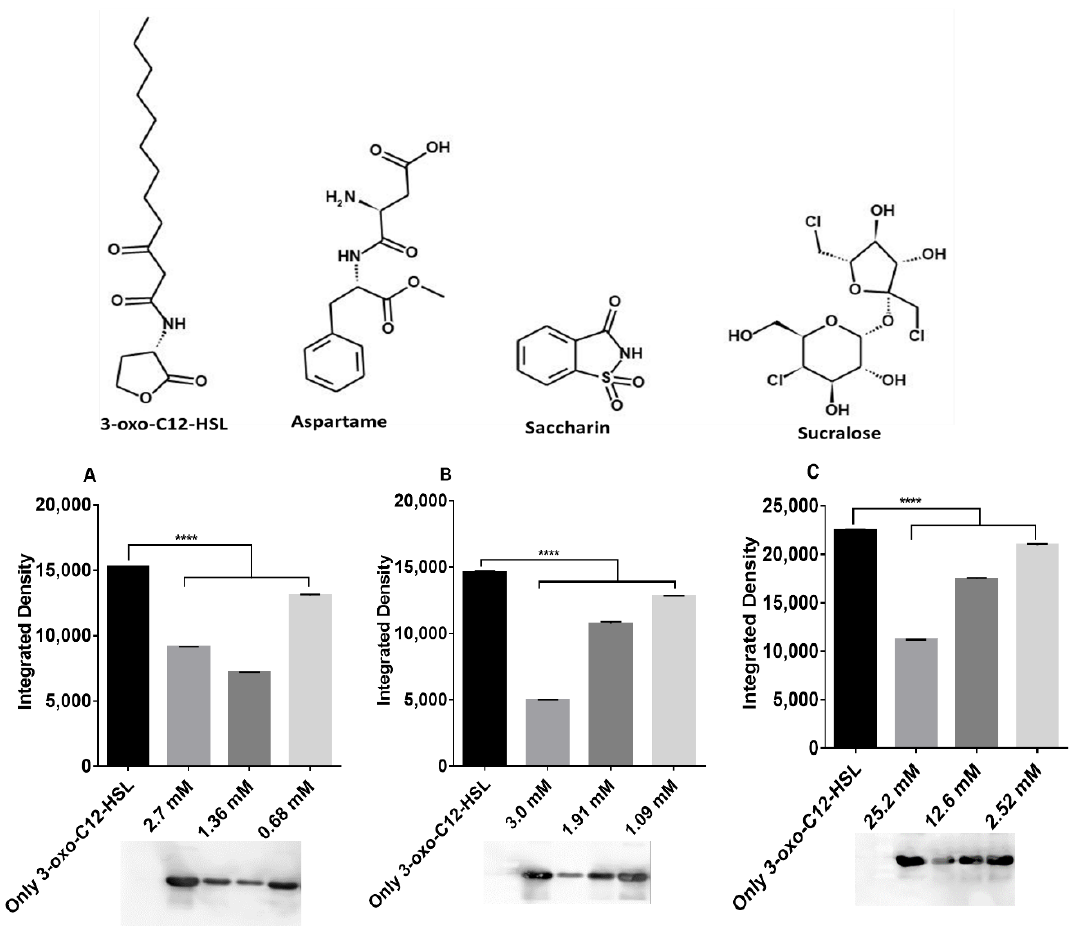
Figure 2. Decrease of LasR-LBD solubility by artificial sweeteners monitored by Western blotting of the soluble fraction from the LasR-LBD overexpression in E. coli BL21 strain in the presence of ( A ) aspartame, ( B ) saccharin, and ( C ) sucralose.